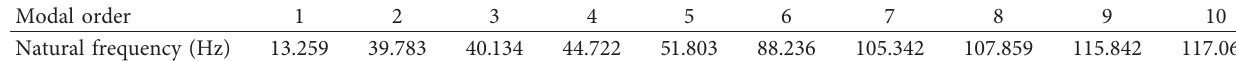
Figure 4: The rate of change of the Fisher Information Matrix 2-norm of the transmission tower. Table 1: First 10 natural frequencies of the transmission tower.